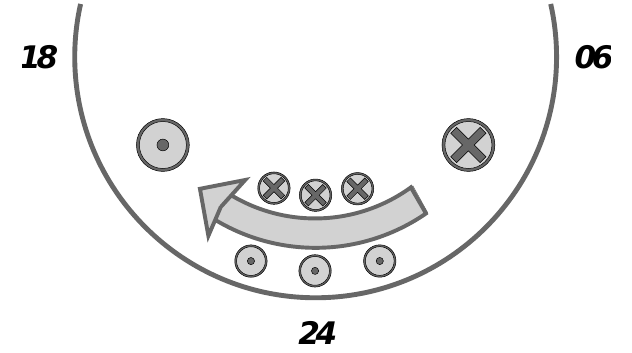
Fig. 6. Schematic drawing of the SC-related auroral current system deduced from our night side magnetic field observations. There seem to be primary FACs, downward at dawn and upward at dusk, that are closed by ionospheric currents. This loop causes poleward pointing magnetic fields at sub-auroral latitudes. North and south of the SC-related current jet we observe FAC